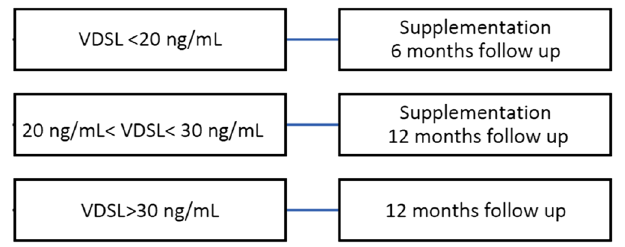
Figure 5. Vitamin D surveillance and